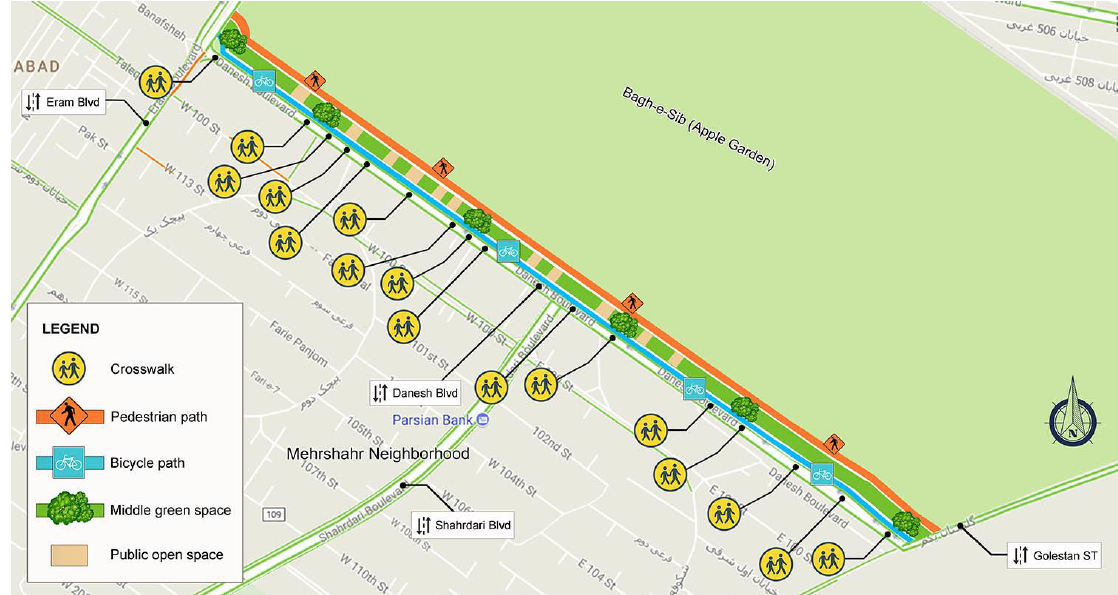
Fig. 1: Danesh Pedestrian and Bicycle Path, and its details